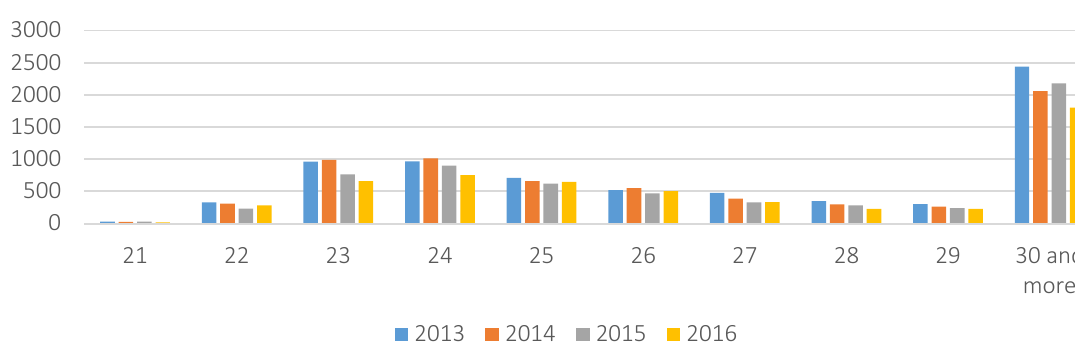
Source: Institute of Statistics of Republic of Srpska